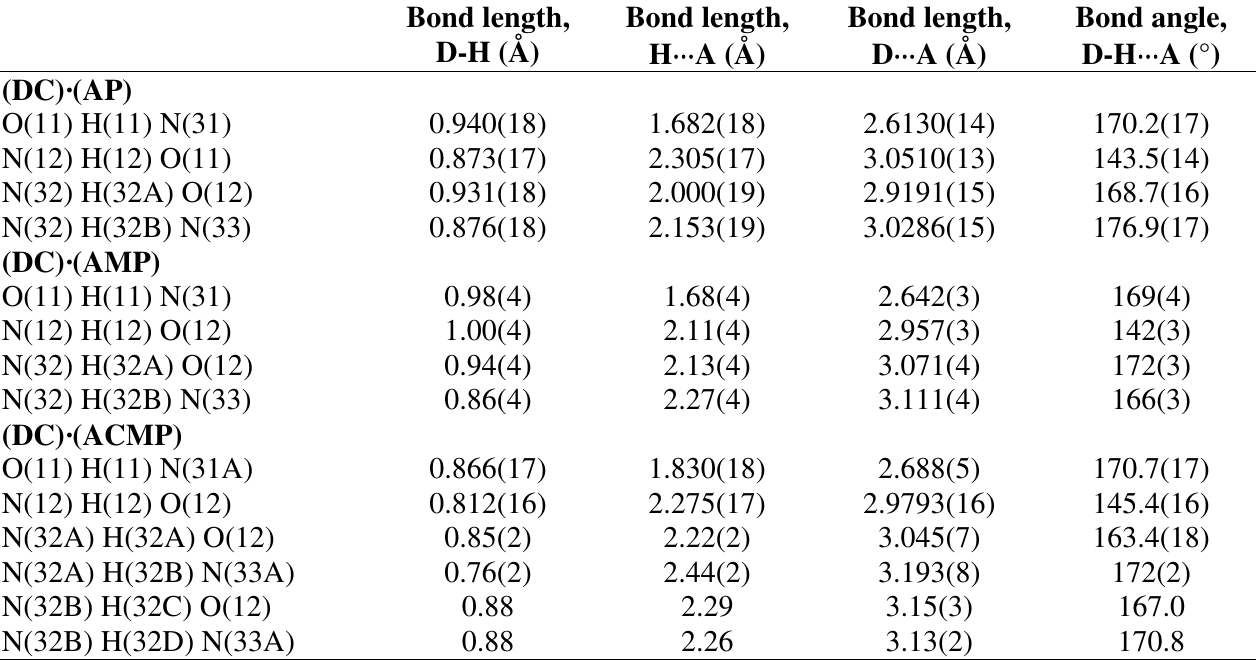
Table 3. Hydrogen Bonds in Diclofenac